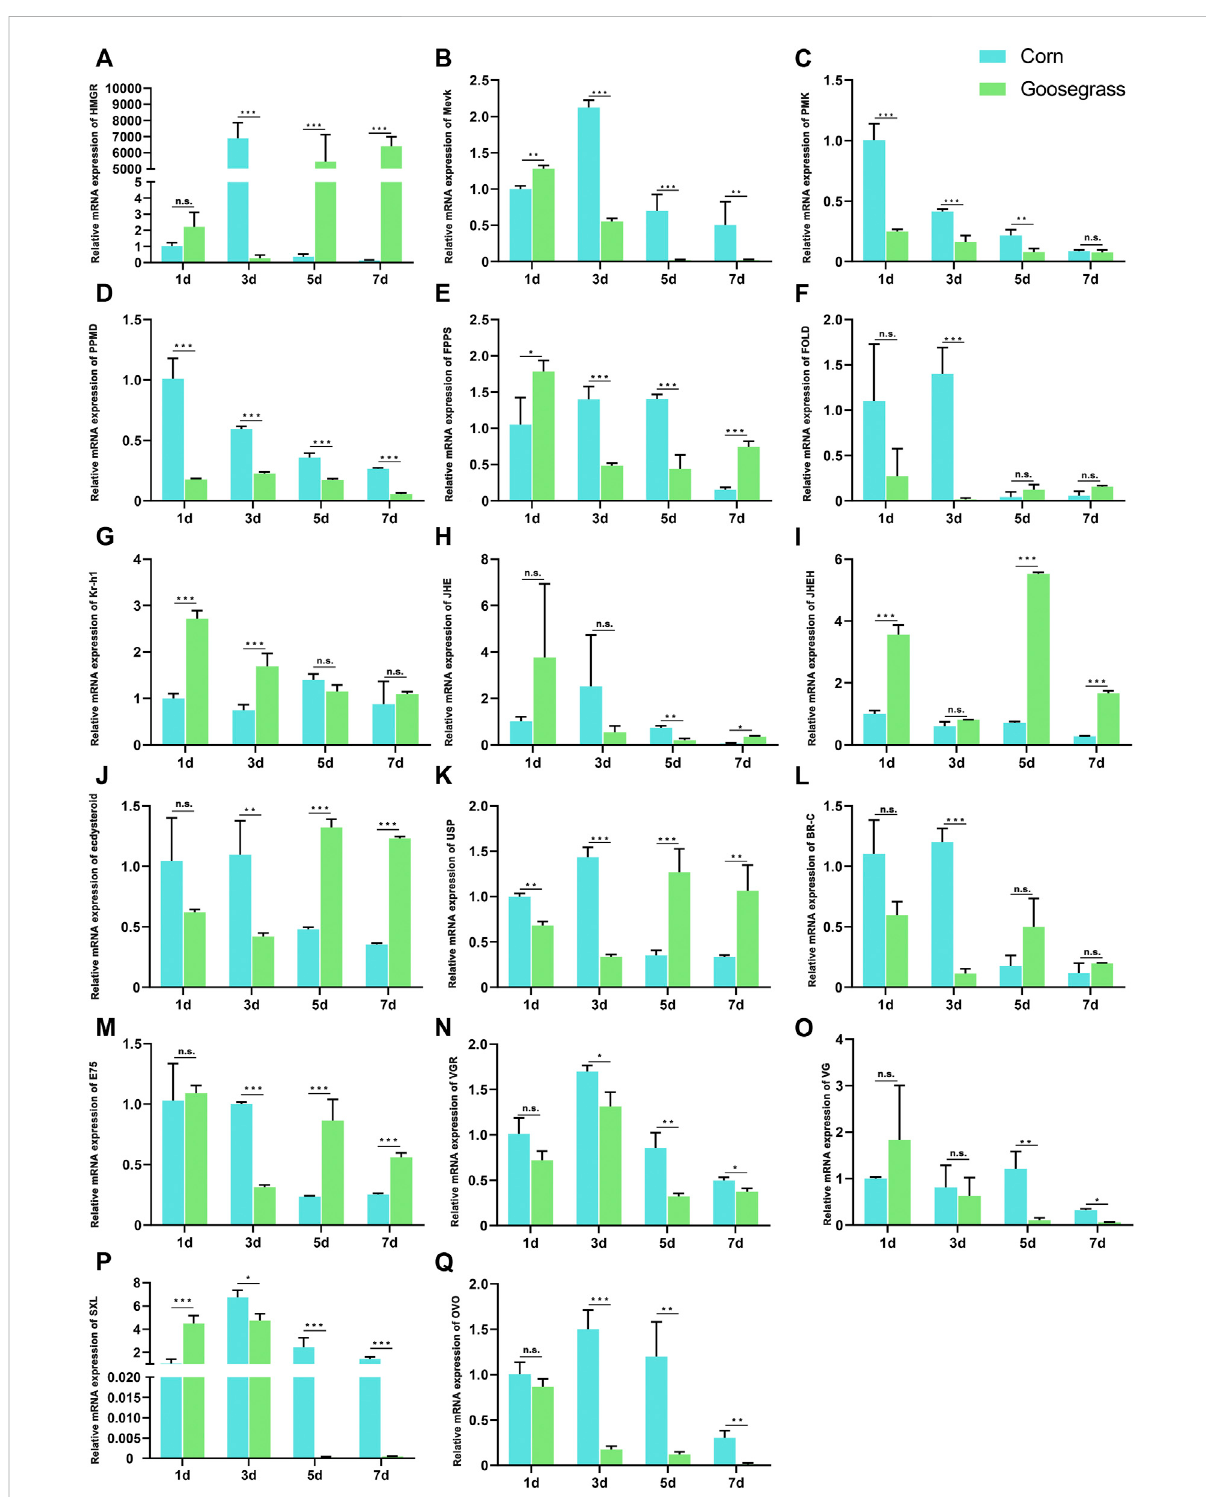
FIGURE 5 Relative expression levels of (A – I) JH-biosynthetic genes, (J – M) 20E-biosynthetic genes, and (N – Q) ovary development-related genes at 1, 3, 5,and7 dpost-eclosiondeterminedbyqRT-PCR.Asterisksindicatesigni fi cantdifferencesbetweenhosts(*, p < 0.05;**, p < 0.01,***;and p <